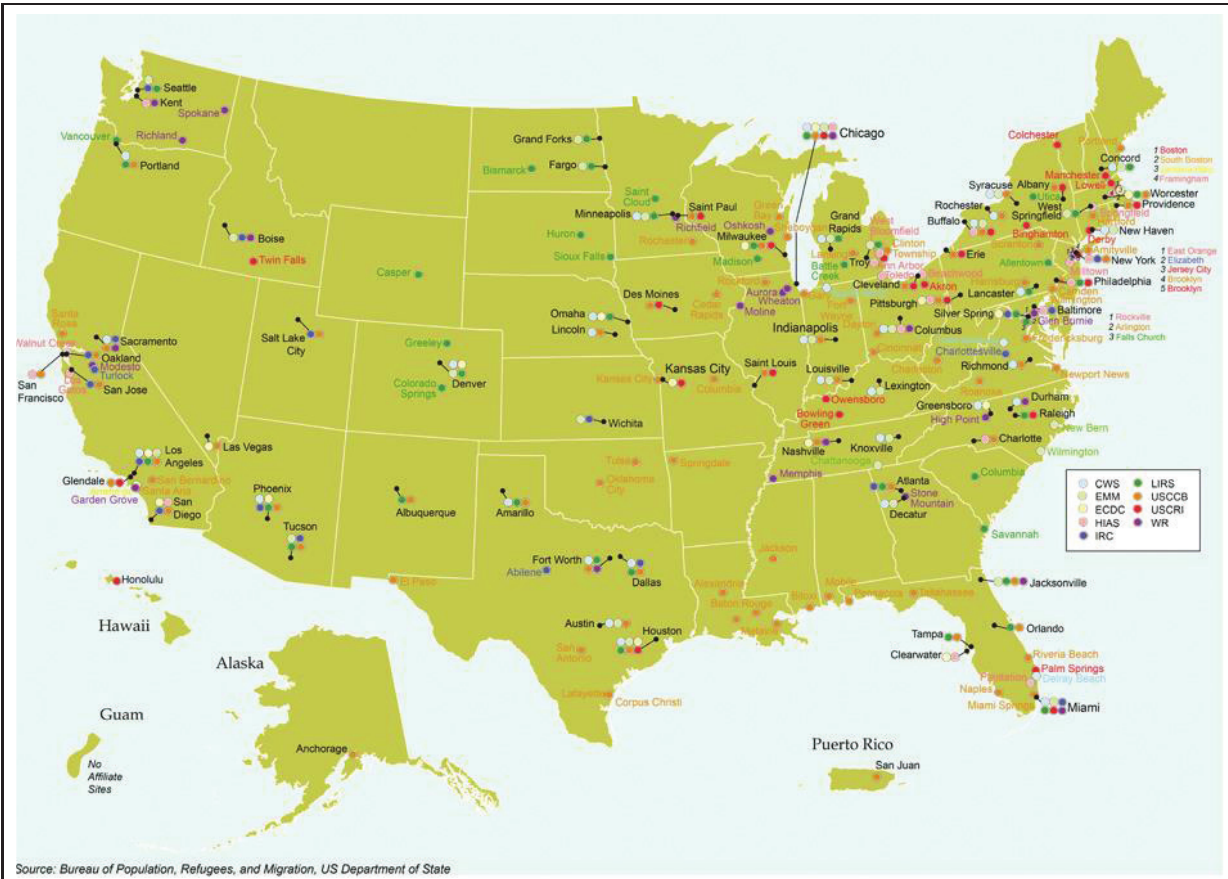
Figure 1 Resettlement sites by volunteer